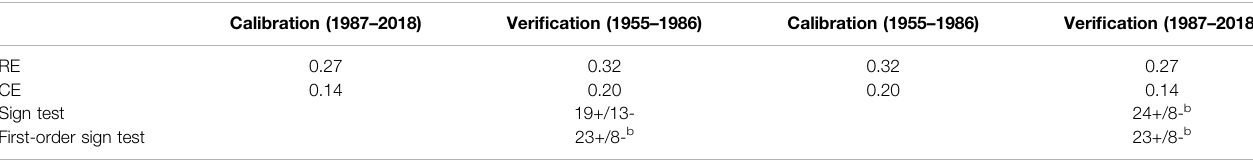
TABLE 2 | Calibration and veri fi cation statistics for the June-July temperature